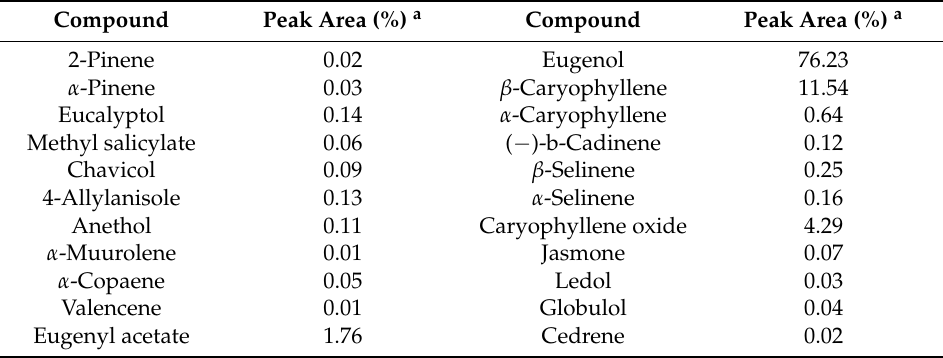
Table 1. Chemical composition of essential oil from clove